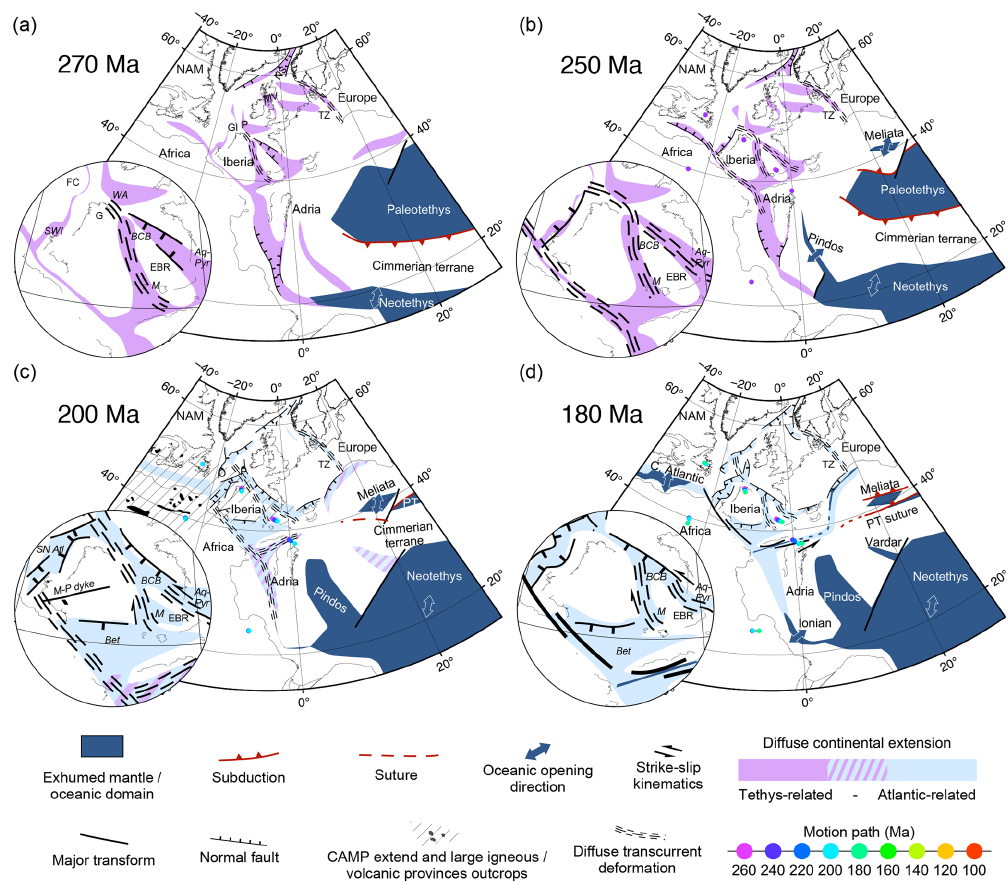
Figure 5. Large-scale reconstruction of the Tethys–Atlantic area for the 270Ma (a) , 250Ma (b) , 200Ma (c) , and 180Ma (d) periods. Maps are in orthographic projection. Closeup shows the evolution of the Iberian plate and the Ebro continental block. Colored background shows diffuse or ill-defined deformation (extension or transtension) in the continents, associated with the evolution of the Tethys (Paleo- and Neotethys, purple) or the Atlantic (blue). At 200Ma, the hatched area represents the CAMP extent. Aq-Pyr: Aquitaine–Pyrenean